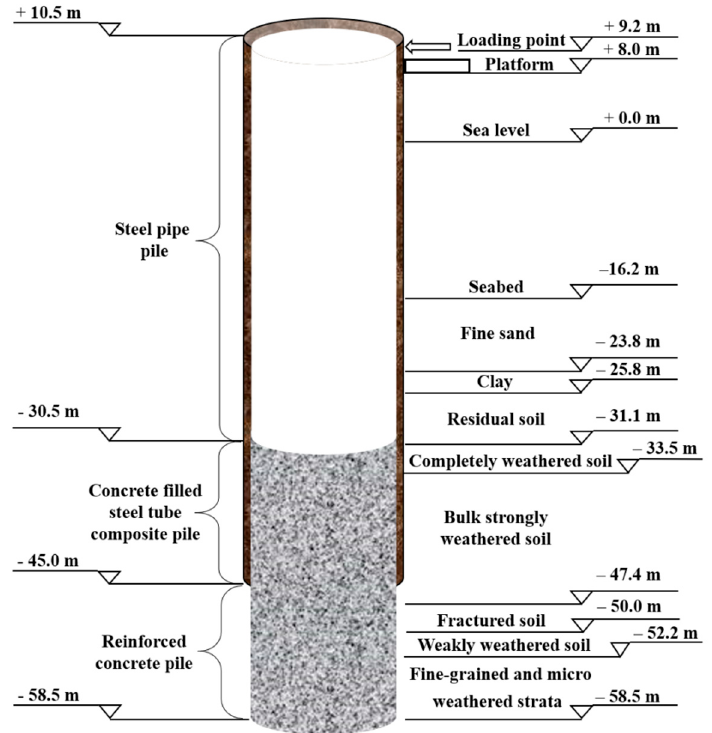
Figure 3. Test pile and geological survey data at different elevations.